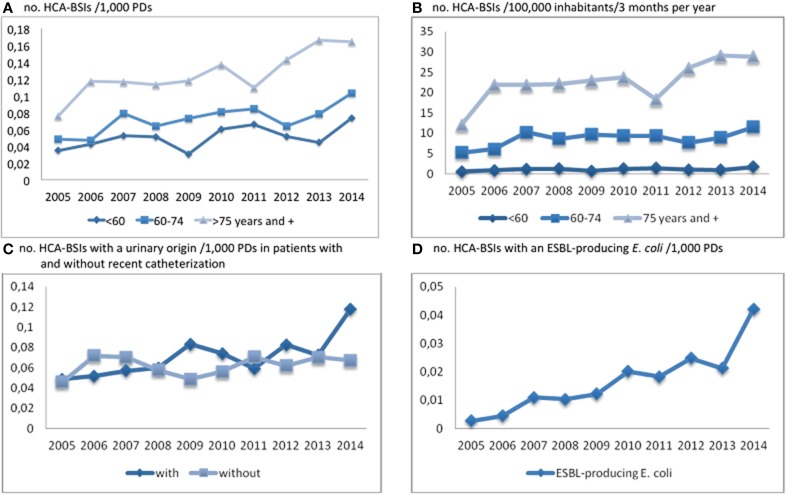
Trends in HCA-BSI incidence (no. of cases/1000 PDs and/100,000 inhabitants/3 months per year) by age group (A and B), for BSIs with a urinary origin in patients with and without recent catheterization (C) and for BSIs with ESBL-producing
E. coli
isolates (D).